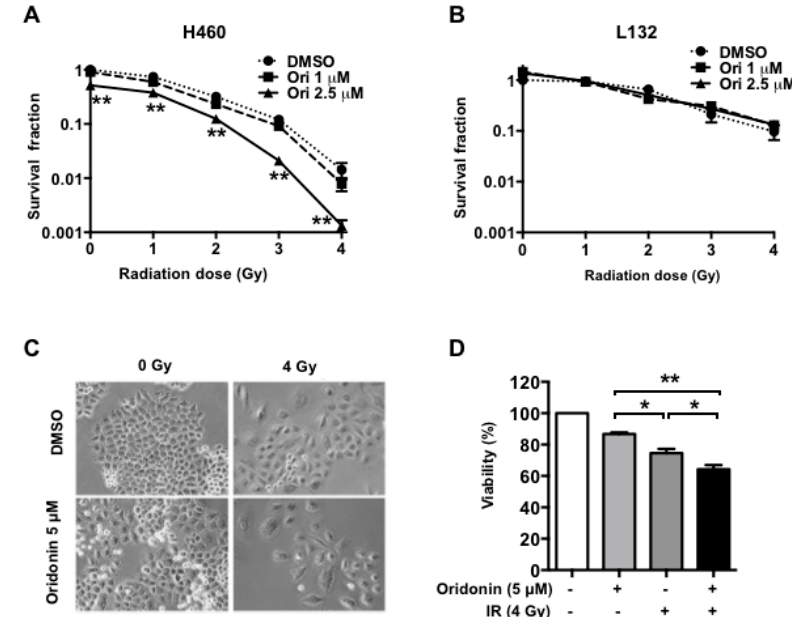
Figure 2. Effect of oridonin on sensitivity of H460 cells to radiation. ( A ) Survival fractions obtained by colony forming assay in H460 cells ( A ) and L132 cells ( B ). ** p < 0.01; p -values represent two-way ANOVA results. ( C ) Representative images of cultured H460 cells in the presence of oridonin (5 µM) and/or radiation (IR, 4 Gy). ( D ) H460 cell viability was measured using an MTT assay. The data are presented as means ± SEM ( n = 3); * p < 0.05 and ** p < 0.01. Three independent experiments were carried out. DMSO, dimethyl sulfoxide vehicle.